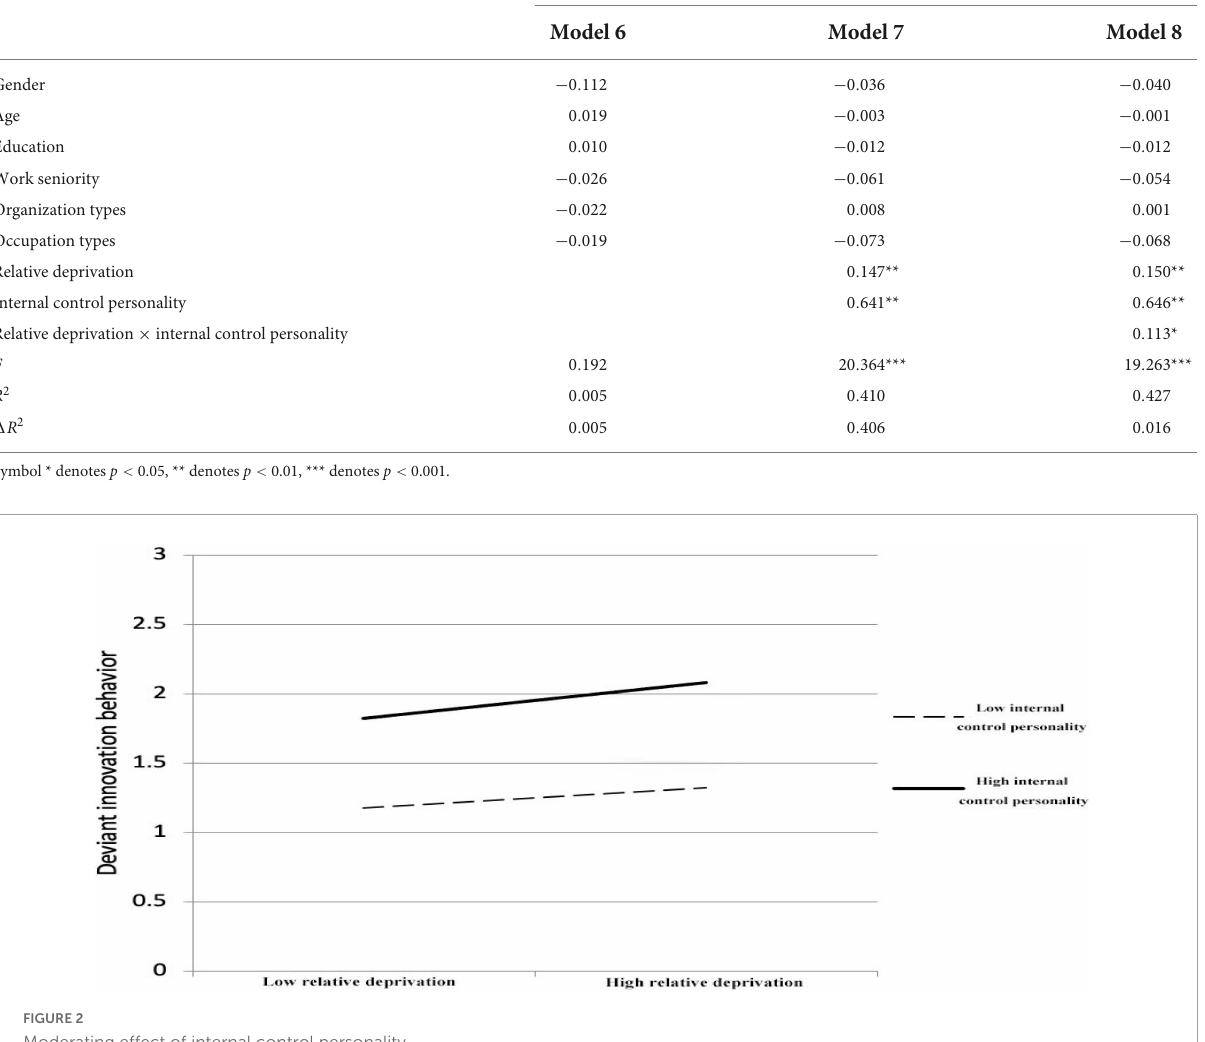
FIGURE2 Moderating effect of internal control personality.